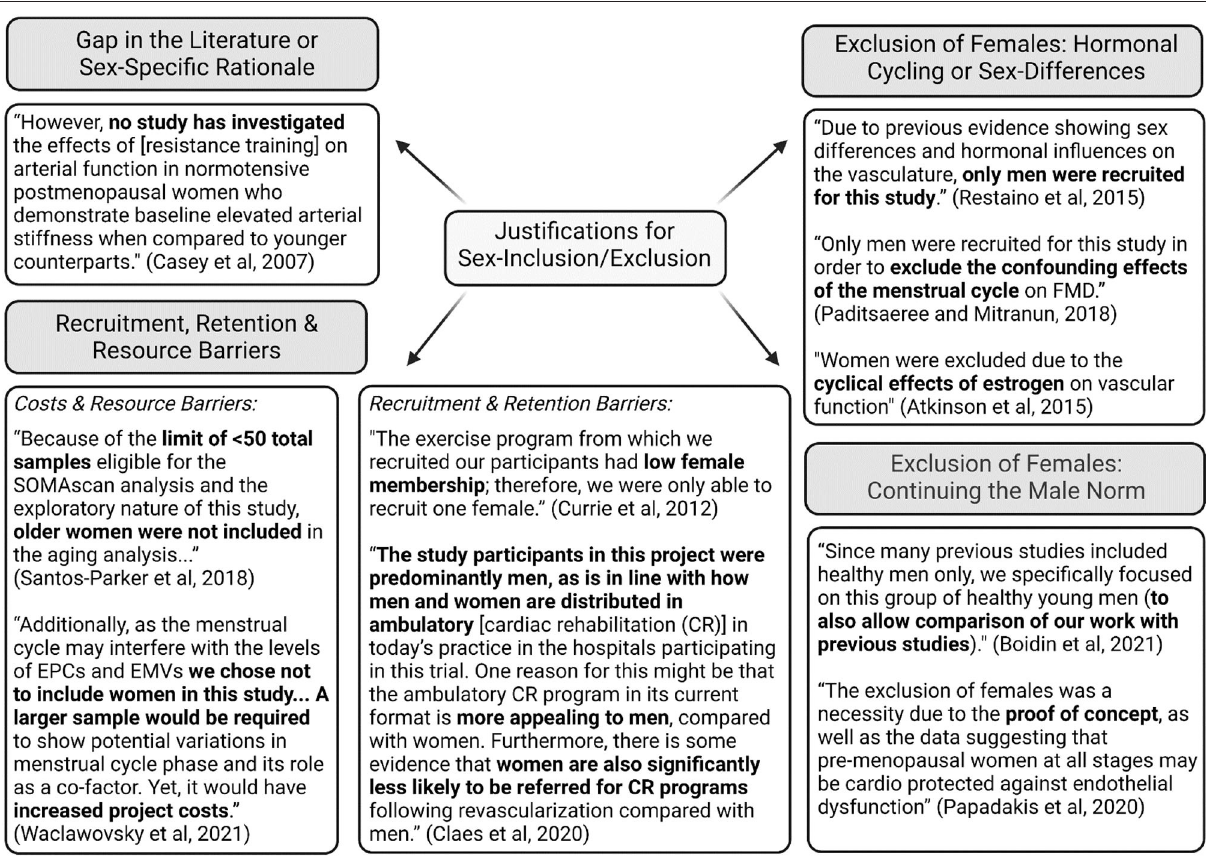
as gender instead of sex or using terms “woman” and “man” as sex instead of gender, or using both the terms “sex” and “gender” interchangeably throughout the paper). In addition, the vast majority of studies did not explicitly examine gender